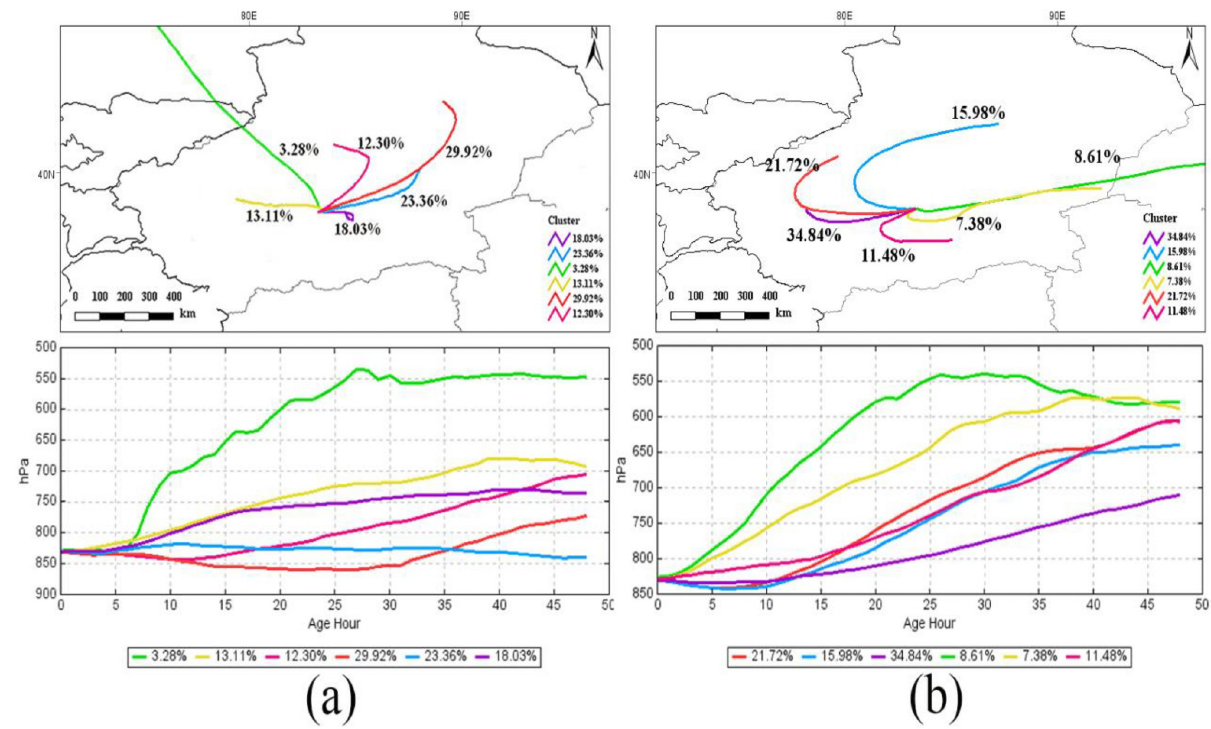
Fig 9. Analysis of the air parcel track from southern Xinjiang in the spring of 2014. (a) backward track and (b) forward track. (The lines in the figure represent paths and the colors represent percentages of clustering. The software is downloaded from http://www.ready.noaa.gov/documents/Tutorial/ html/install_win.html.. Map credit: Jinglong